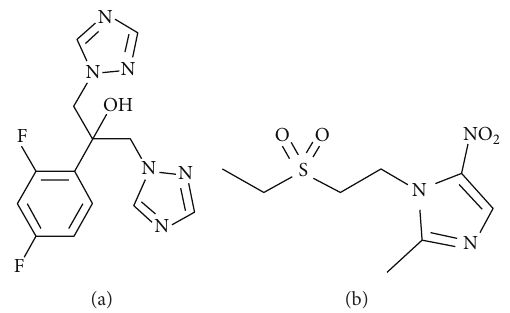
Figure 1: Chemical structure of fluconazole (a) and tinidazole